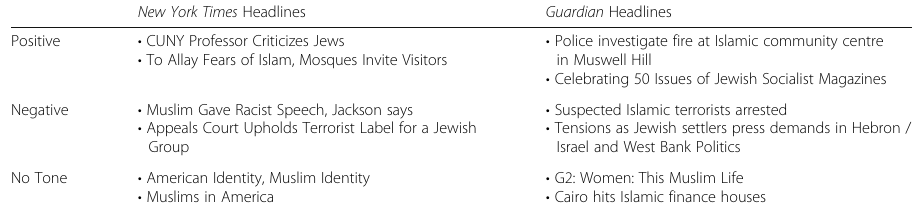
Table 2 Examples of Headlines with a Positive, Negative, or No